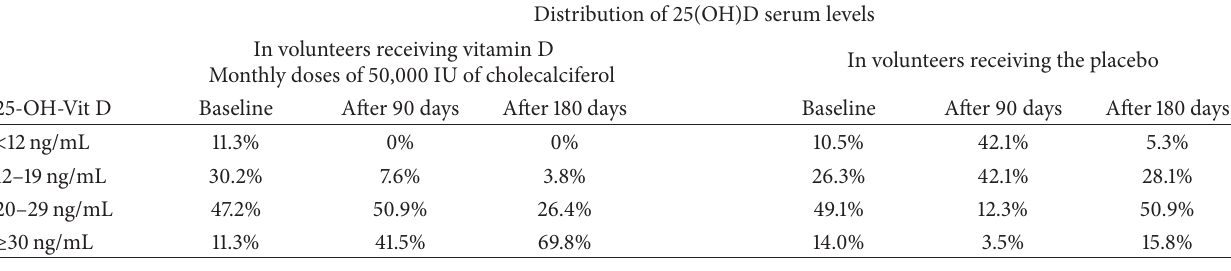
Table 3: Percentage of patients whose 25(OH)D levels were found in the < 12, 20–30, and > 30ng/mL groups in the vitamin D or placebo group. One patient presented a 25(OH)D level > 60ng/mL in October and another one in May.